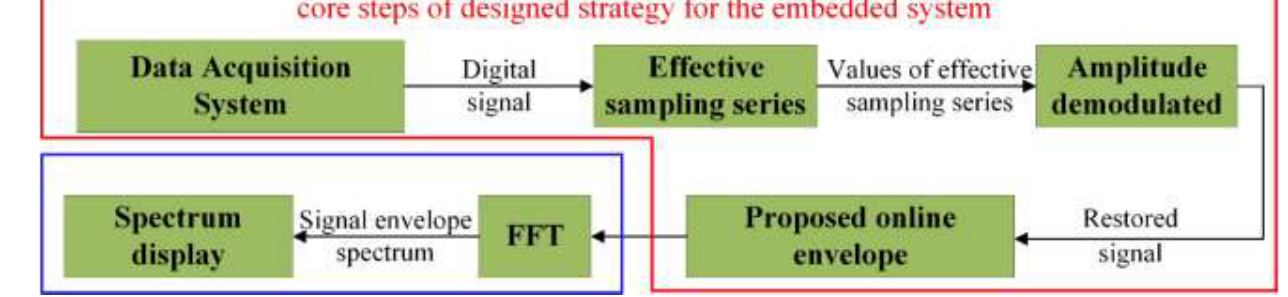
Figure 4. The flow chart of the algorithm for the designed embedded system.